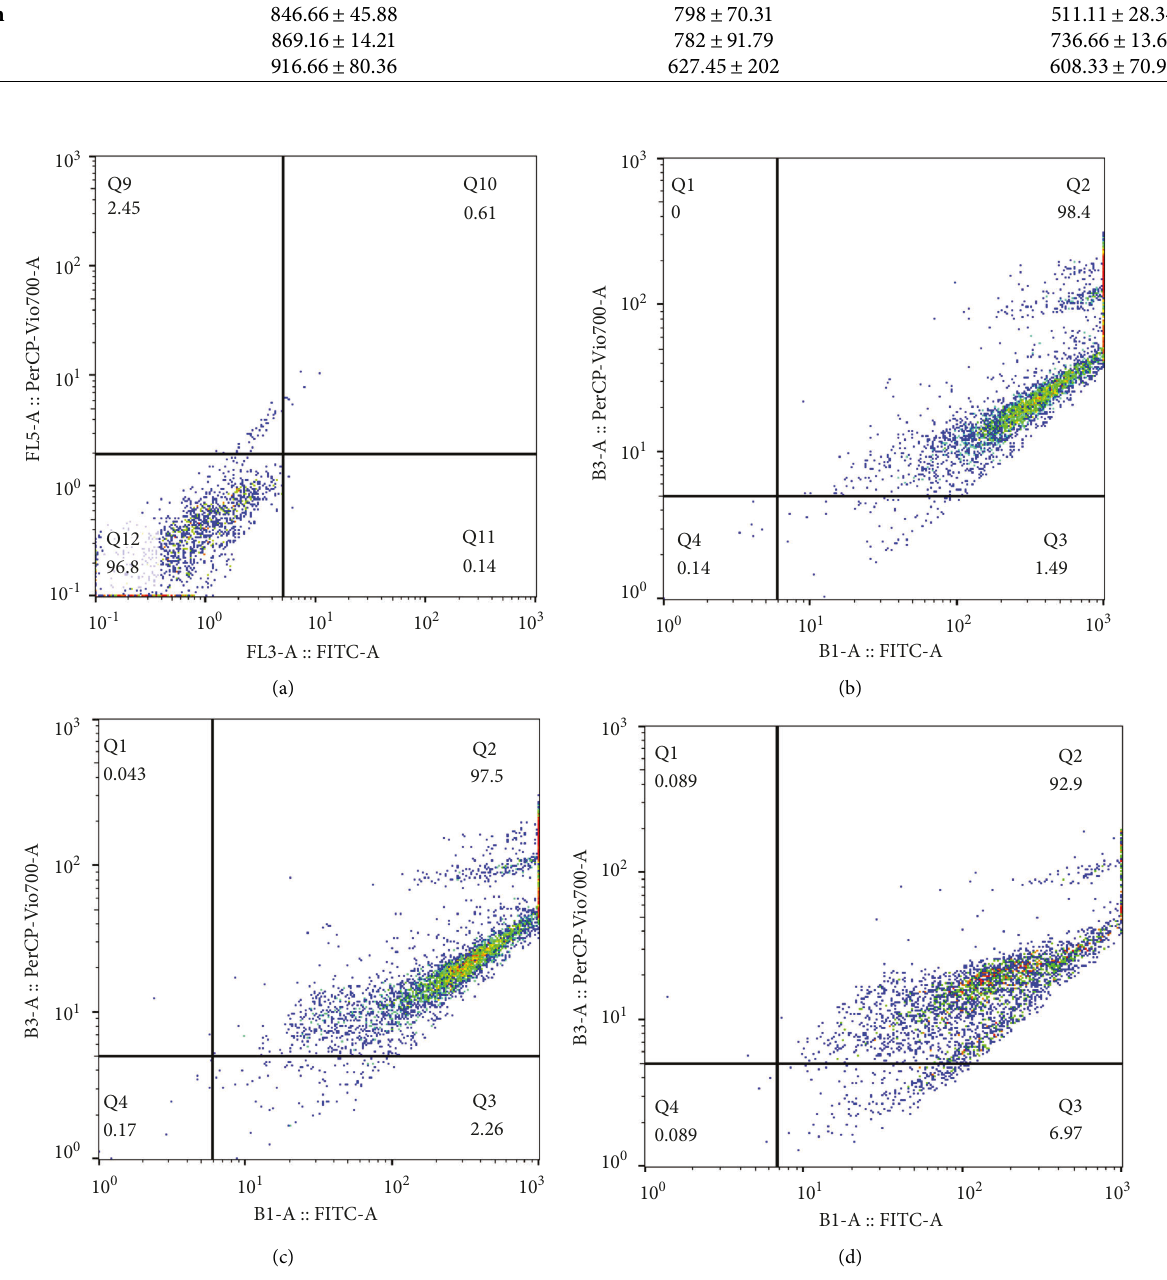
Figure 1: Effect of treatment of phenolic acids on HepG2 cells viability. (a) Negative control, cell (b) Ca, (c) Fer, and (d) Cum. Annexin V and 7-AAD staining was represented by flow cytometry, panel: Q 1 � necrotic; Q2: late apoptotic cells; Q3: early stage apoptotic cells; Q4: normal viable cells.